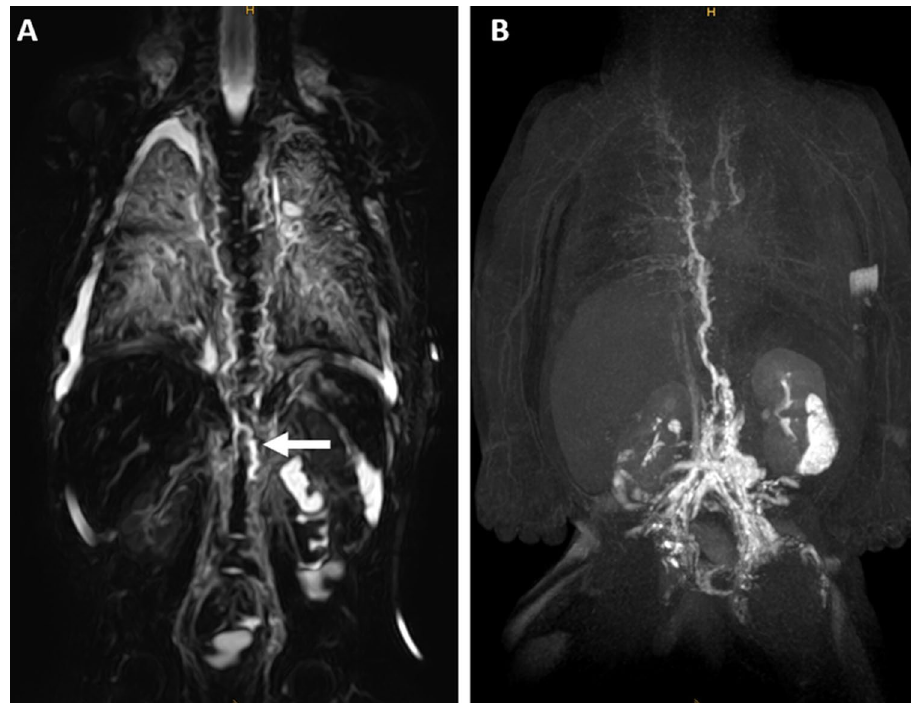
Figure 1. Two-month-old boy with Noonan syndrome-associated bilateral chylothorax and pulmonary lymphangiectasia. ( A ) Coronal, T2-weighted, non-contrast imaging demonstrates the right-sided course of the thoracic duct from the cisterna chyli (arrow) into the middle part of the thorax where it can no longer be distinguished from surrounding edema. Observe also the extensive pulmonary abnormalities and bilateral pleural effusions. ( B ) Coronal maximum-intensity projection (MIP) of a contrast-enhanced MR-lymphangiogram demonstrating dilated retroperitoneal lymphatics, the dilated cisterna chyli and thoracic duct in the lower and middle part of the thorax. The thoracic duct runs entirely on the right side and is only rudimentary in the upper part of the thorax. There is also cross-flow through mediastinal lymphatics to the left venous junction. There is only faint enhancement of cervical lymphatics without a discernable TD-venous junction of the thoracic duct. Observe also faint reflux into bilateral intercostal lymphatics and peribronchial lymphatics on the